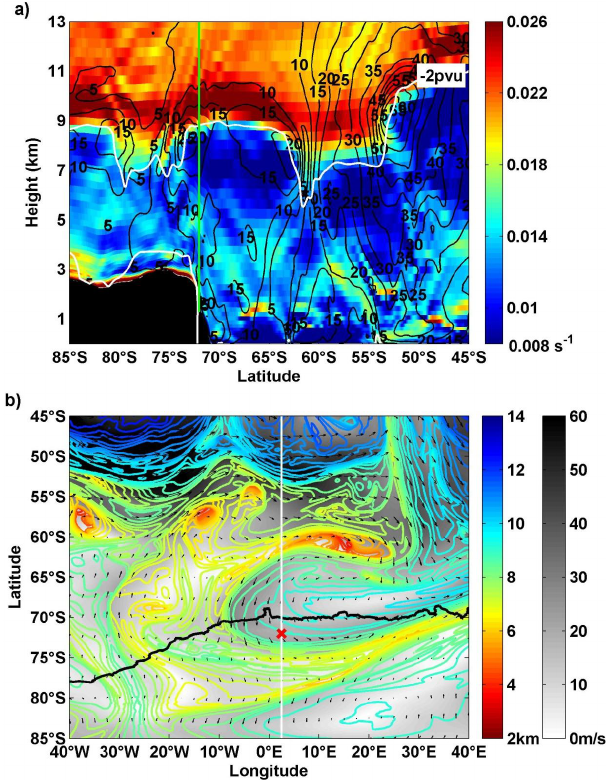
Fig. 4. ECMWF analysis on 25 January 2012 00:00UTC. (a) Ver- tical cross section of buoyancy frequency along 2.5 ◦ E longitude. White line shows the dynamical tropopause level ( − 2pvu), and wind speed contours are indicated in black. Vertical green line rep- resents the position of MARA measurements. (b) shows the height, wind speed and direction at the dynamical tropopause level. MARA position is indicated a by red cross, and the vertical white line rep- resents the position of the cross section in (a)